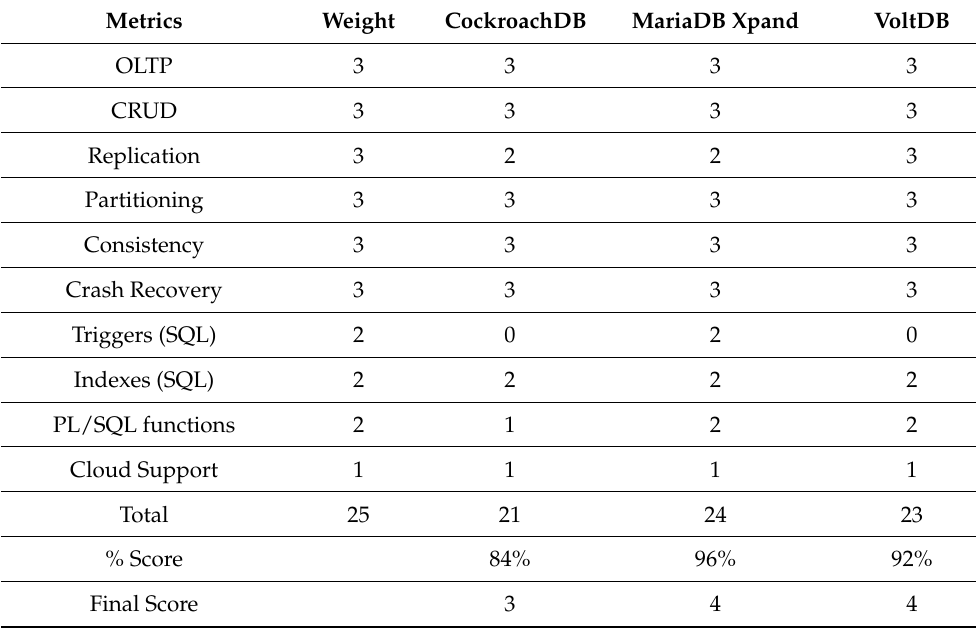
Table 3. Functionality metrics.